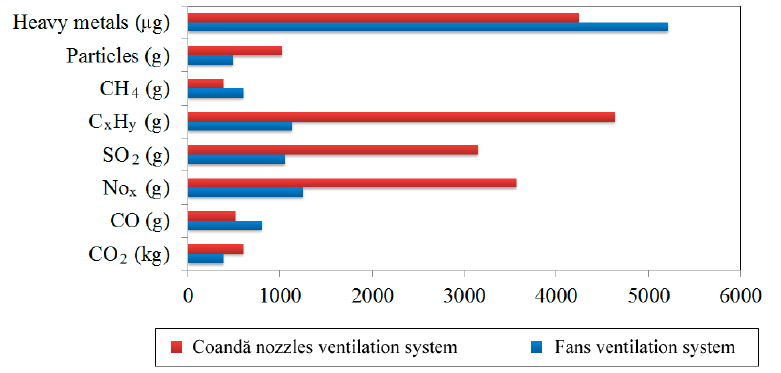
Figure 12. Total emissions from the production of materials over the 25 year life cycle.